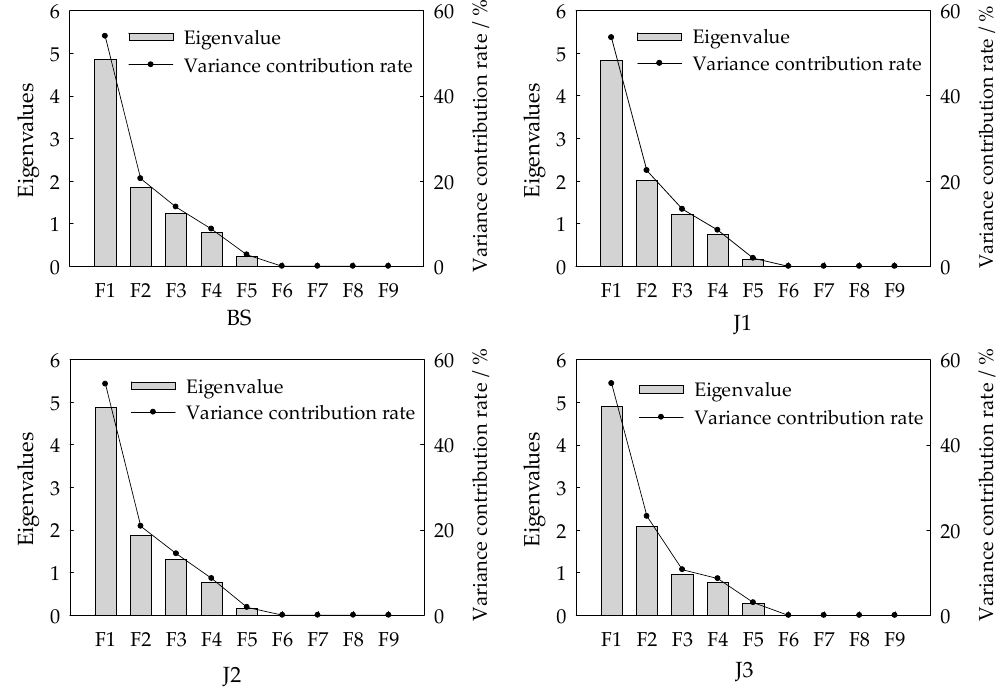
Figure 8. Variance contribution rate and eigenvalues in P2.